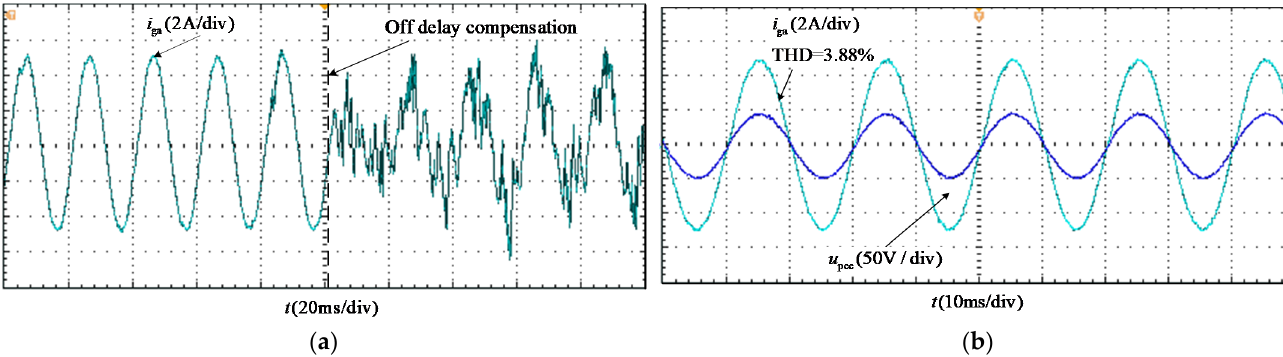
Figure 12. Experimental results under strong grid: ( a ) switching of delay compensation links; ( b ) network current and PCC voltage at steady state.